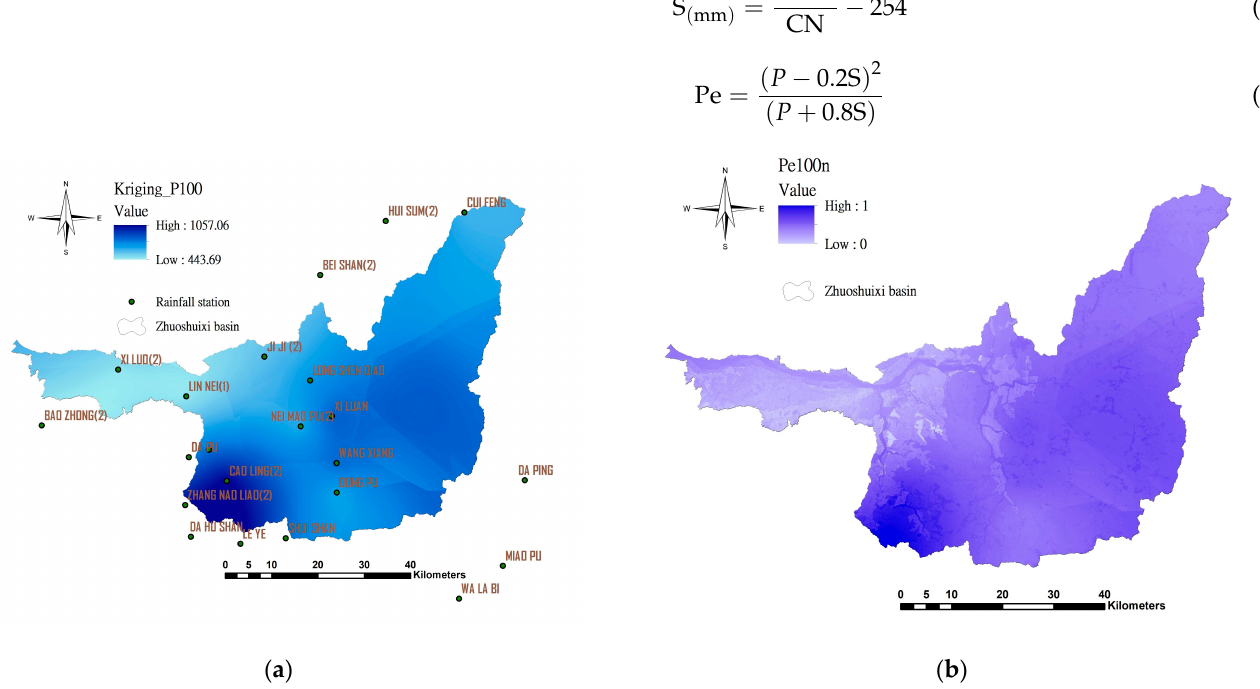
Figure 4. The rainfall, excess runoff, and normalized excess runoff diagram of Zhuoshuixi Basin during the 100-year return period: ( a ) rainfall distribution map of Kriging analysis; ( b ) the normalized spatial distribution of excess rainfall calculated by SCS-CN method.